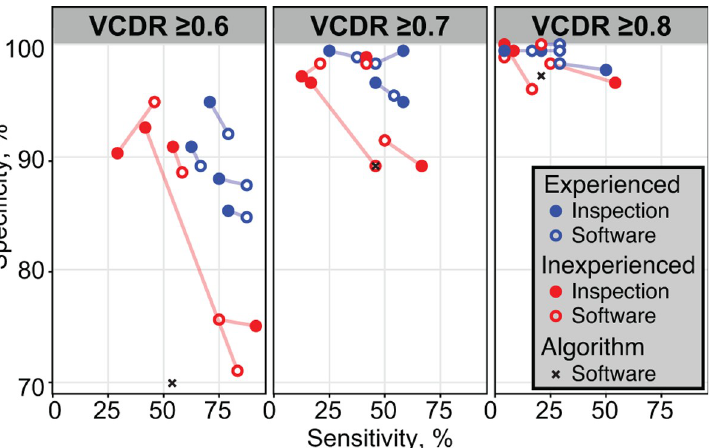
Fig 4. Diagnostic accuracy for classification of optic disk cupping. Four individuals with and four individuals without clinical experience graded a set of fundus photographs for vertical cup-to-disk ratio (VCDR) using two different methods: visual inspection and with software assistance. The sensitivity and specificity for each grader was calculated relative to a reference standard VCDR of � 0.7, assessed as the median of five ophthalmologists grades. A pair of points is shown for each grader, with the filled circle representing visual inspection, the empty circle representing software-assisted grading, and a line joining the pair. An automated algorithm was used to classify VCDR. The three graphs show the sensitivity and specificity for three different thresholds of cupping; note that a perfectly sensitive and specific test would be located in the upper right-hand corner of each plot.